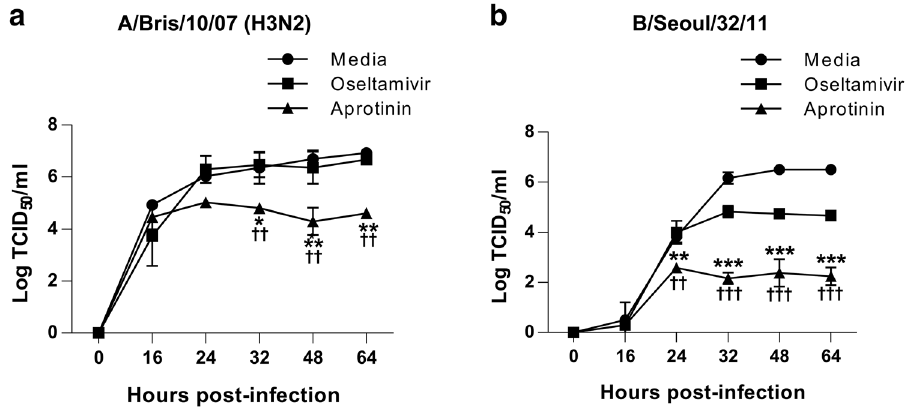
Figure 4. Aprotinin inhibited the replication of oseltamivir-resistant influenza viruses in Madin–Darby canine kidney (MDCK) cells. The replication kinetics of ( a ) A/Bris/10/07 (H3N2) and ( b ) B/Seoul/32/11 were investigated in MDCK cells after treatment with aprotinin and oseltamivir. MDCK cells were infected with influenza virus at an MOI of 0.01 (H3N2) or 0.001 (B/Seoul/32/11) for 1 h and then treated with aprotinin (60 nM) or oseltamivir (100 μM). Supernatants were collected pre-infection (0) and at 16, 24, 32, 48, and 64 h post-infection, and viral titers in the supernatants were determined by the TCID 50 assay. * P < 0.05, ** P < 0.01, and *** P < 0.0001, statistically significant difference between the virus-only (media) group and the aprotinin treatment group. † P < 0.05, †† P < 0.01, and ††† P < 0.0001, statistically significant difference between the aprotinin and oseltamivir treatment groups. MOI: multiplicity of infection; TCID 50 : half-maximal tissue culture infectious dose.